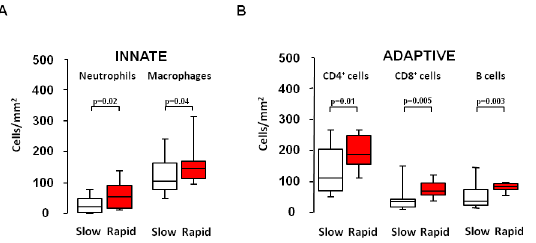
Fig 3. Differential Inflammatory cells in slow and rapid progressors. Number of innate inflammatory cells (neutrophils and macrophages) and adaptive inflammatory cells (CD4 + , CD8 + , and B lymphocyte) in the lungs of slow and rapid progressors. Horizontal bars represent median values, bottom and top of each box plot 25 th and 75 th , brackets 10 th and 90 th percentiles. Slow: white; rapid: red.